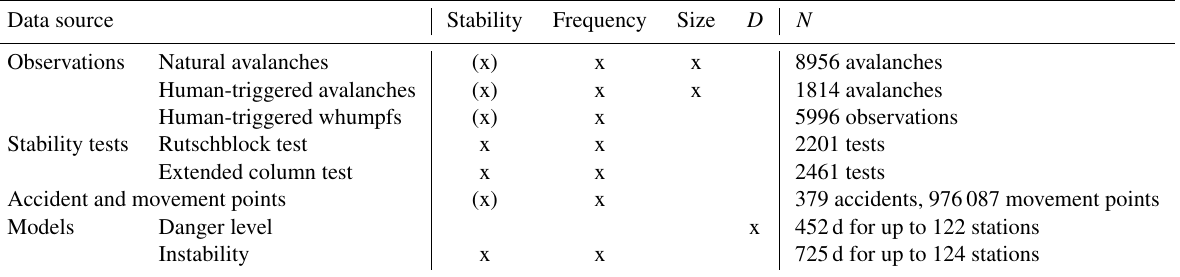
Table 1. Overview showing the analyzed data sources and the contributing factors of avalanche hazard (snowpack stability, the frequency of snowpack stability, avalanche size) for which we consider the respective data sources to be a proxy. x refers to a contributing factor which was analyzed, and (x) to a factor which is included in the variable but does not vary (i.e., for natural avalanches the stability class (type of trigger) is constant and thus natural release